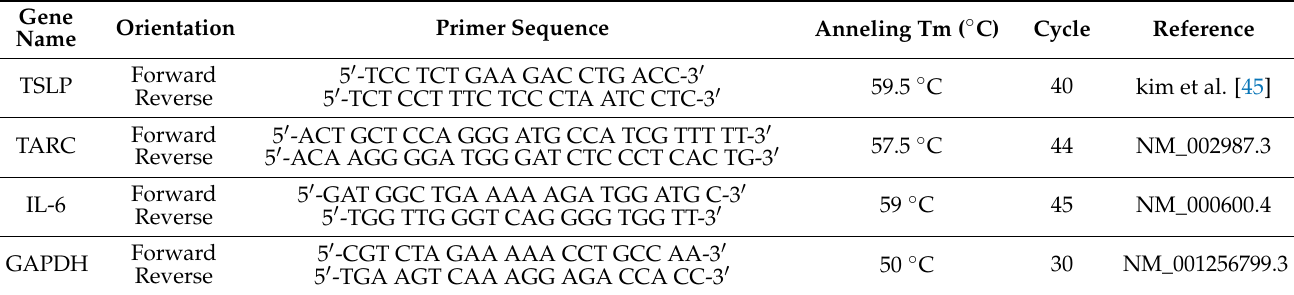
Table 1. Primer Sequence and PCR